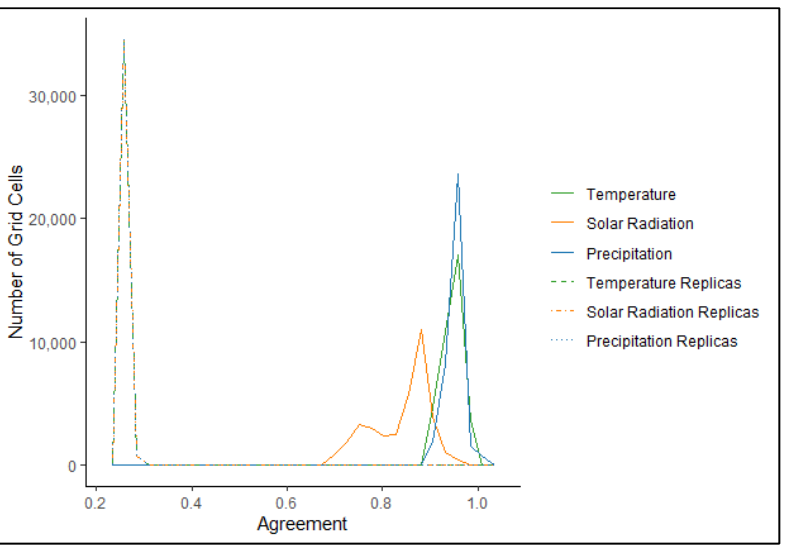
Figure 3. Agreement ( (cid:2267) ) distributions for all meteorological variables. Solid lines represent the distribution of the agreement values for the 36,000 grid cells of the original data, while dotted lines show the distribution of the average agreement of the bootstrap replicas (B = 10) for each grid cell and for each variable.